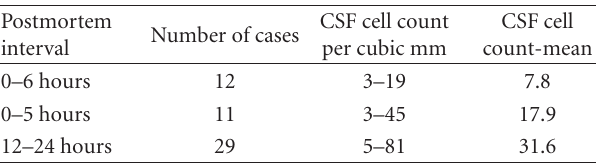
Table 2: Data from Wyler et al